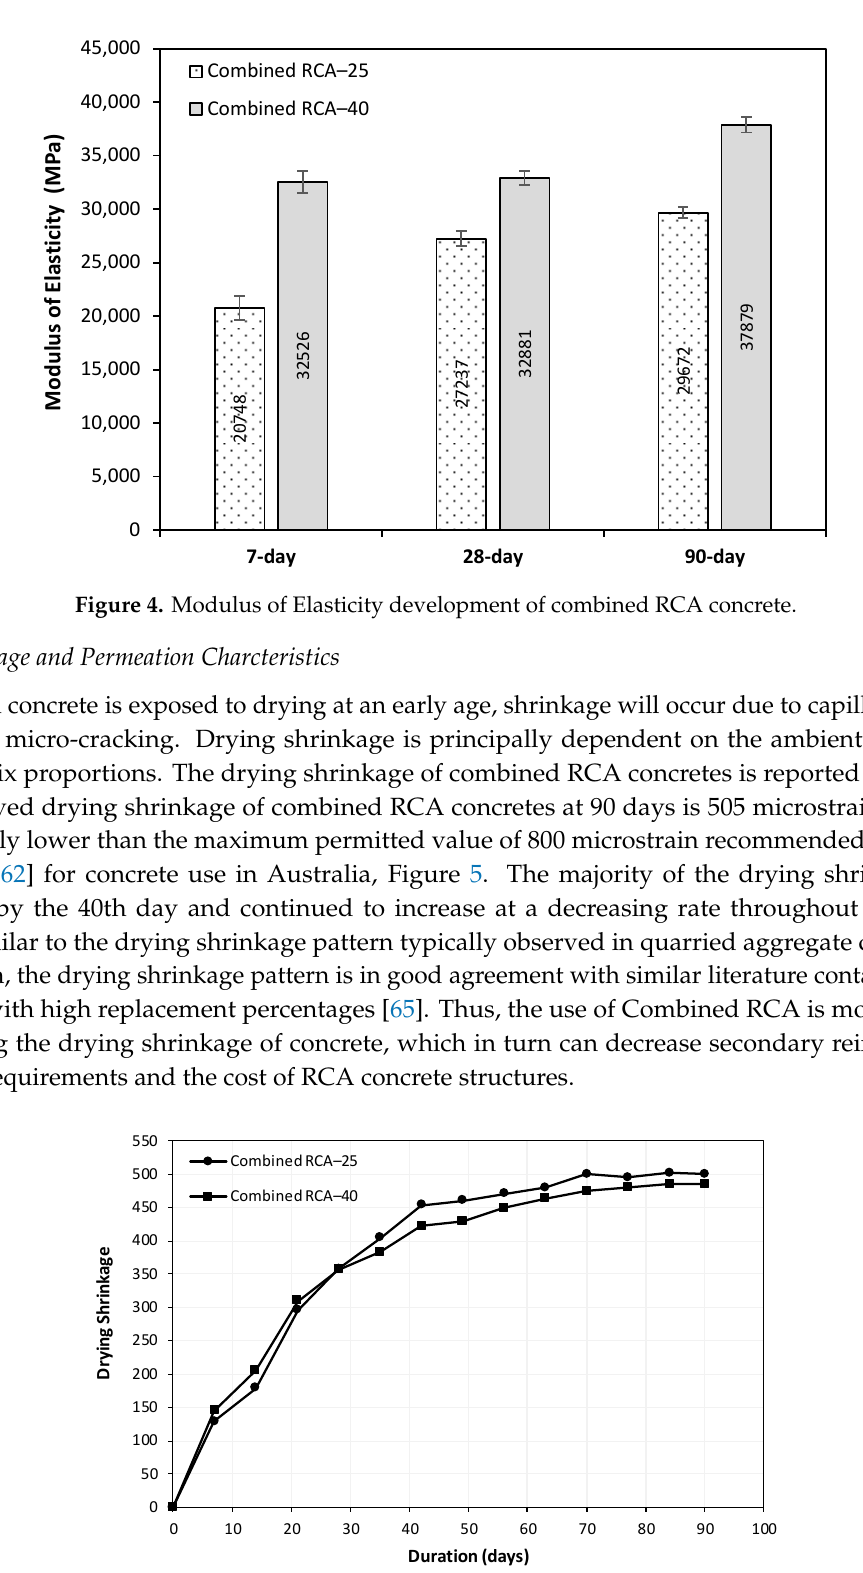
Figure 5. Drying shrinkage of combined RCA concrete.